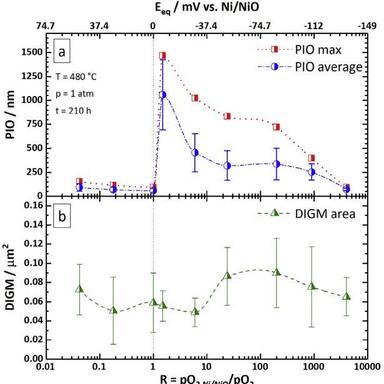
a) PIO as function of the oxidizing ratio R. The red, dotted line represents the maximum PIO detected whilst the blue, dotted curve is the average PIO. b) DIGM as a function of the oxidizing ratio R. (For interpretation of the references to colour in this figure legend, the reader is referred to the Web version of this article.)